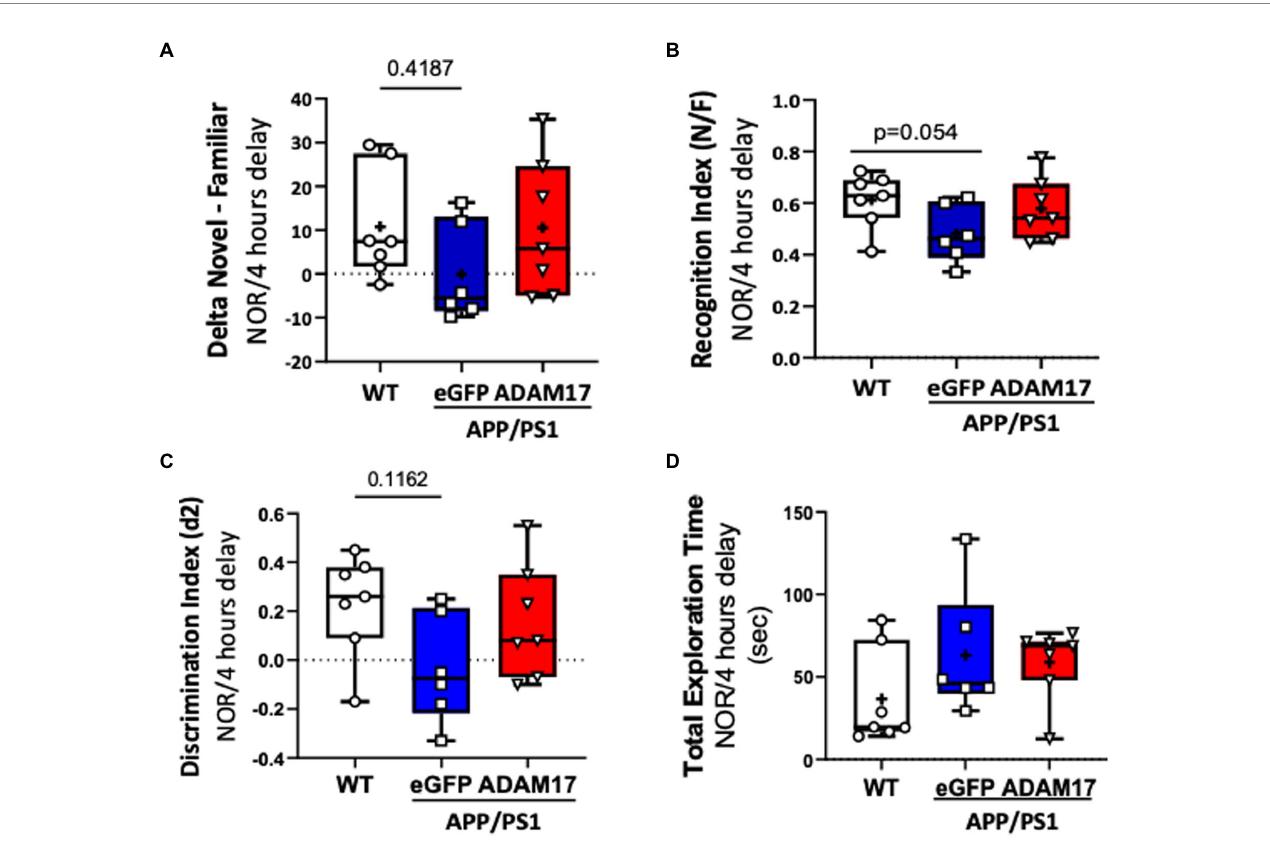
FIGURE 4 Increased ADAM17 expression in APP/PS1 mice improves performance in Novel Object Recognition test. (A,B) There was reduced time to explore the novel object and a reduced recognition index in the eGFP-AAV9 injected, but not in the ADAM17-AAV9 injected, APP/PS1 mice in a NOR test [Delta Novel – Familiar score, Recognition Index (Novel/Familiar, N/F)]. (C) There was decrease in the discrimination index (d2 ratio). (D) There was no change in Total Exploration Time between the three experimental groups. n =6 − 7. Two way ANOVA was